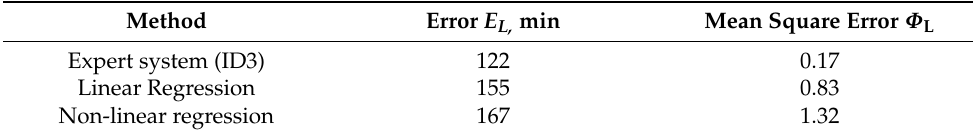
Table 3. The results of the welding time prediction for the exemplary I heating group 145 °C. Method